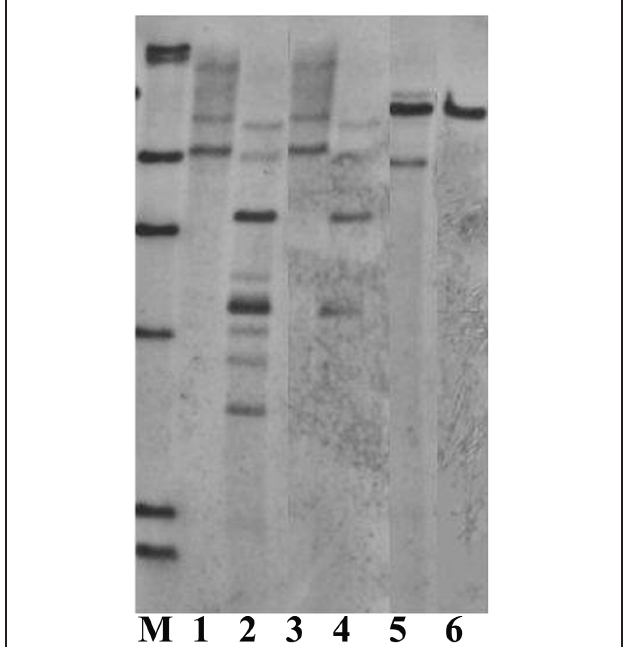
FIGURE 6 | Southern blot analysis on DNAs from 3 different transgenic lines (one transgenic line for one enzyme), digested with different amounts of the enzymes. M, DIG labeled molecular markers. Lane 1: Pst I, 20 µ l; Lane 2: Kpn I, 20 µ l; Lane 3: Pst I, 10 µ l; Lane 4: Kpn I, 10 µ l; Lane